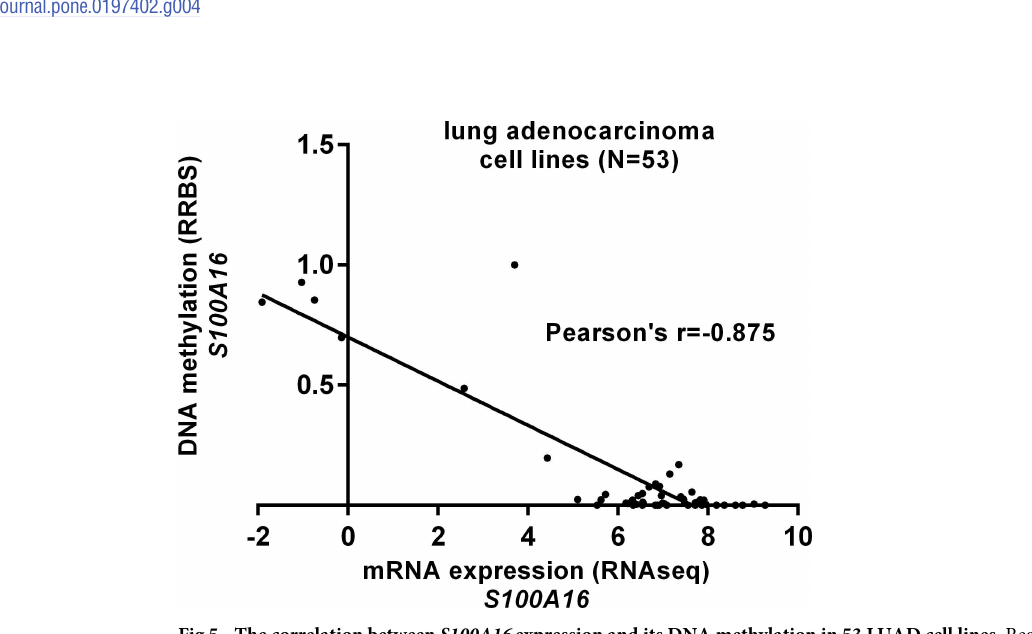
Fig 5. The correlation between S100A16 expression and its DNA methylation in 53 LUAD cell lines. Regression analysis of the correlation between S100A16 expression and its DNA methylation in 53 LUAD cell lines. RRBS: Reduced representation bisulfite